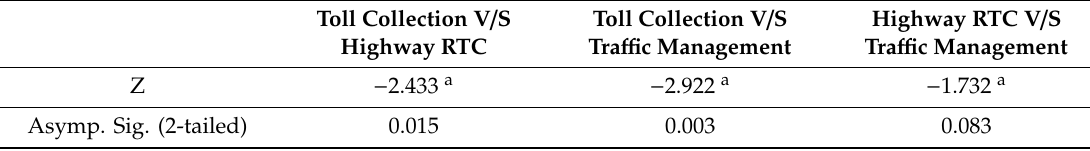
Table 7. Wilcoxon Signed-rank test (Statistics) for